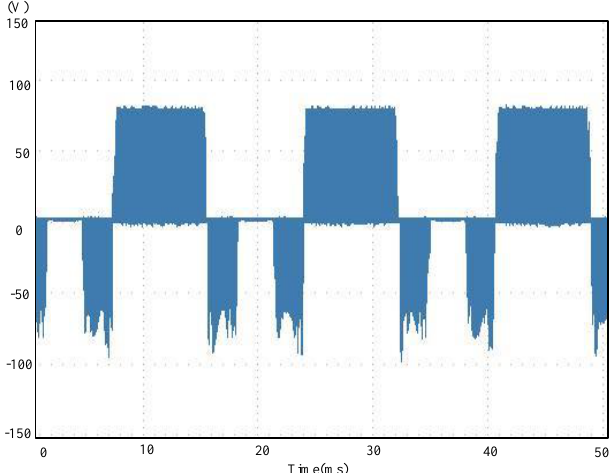
Figure 7. Waveform of the b − phase output voltage ( v bo ) of the inverter at a working frequency of 60 Hz with a fault in switch S b 2 − .